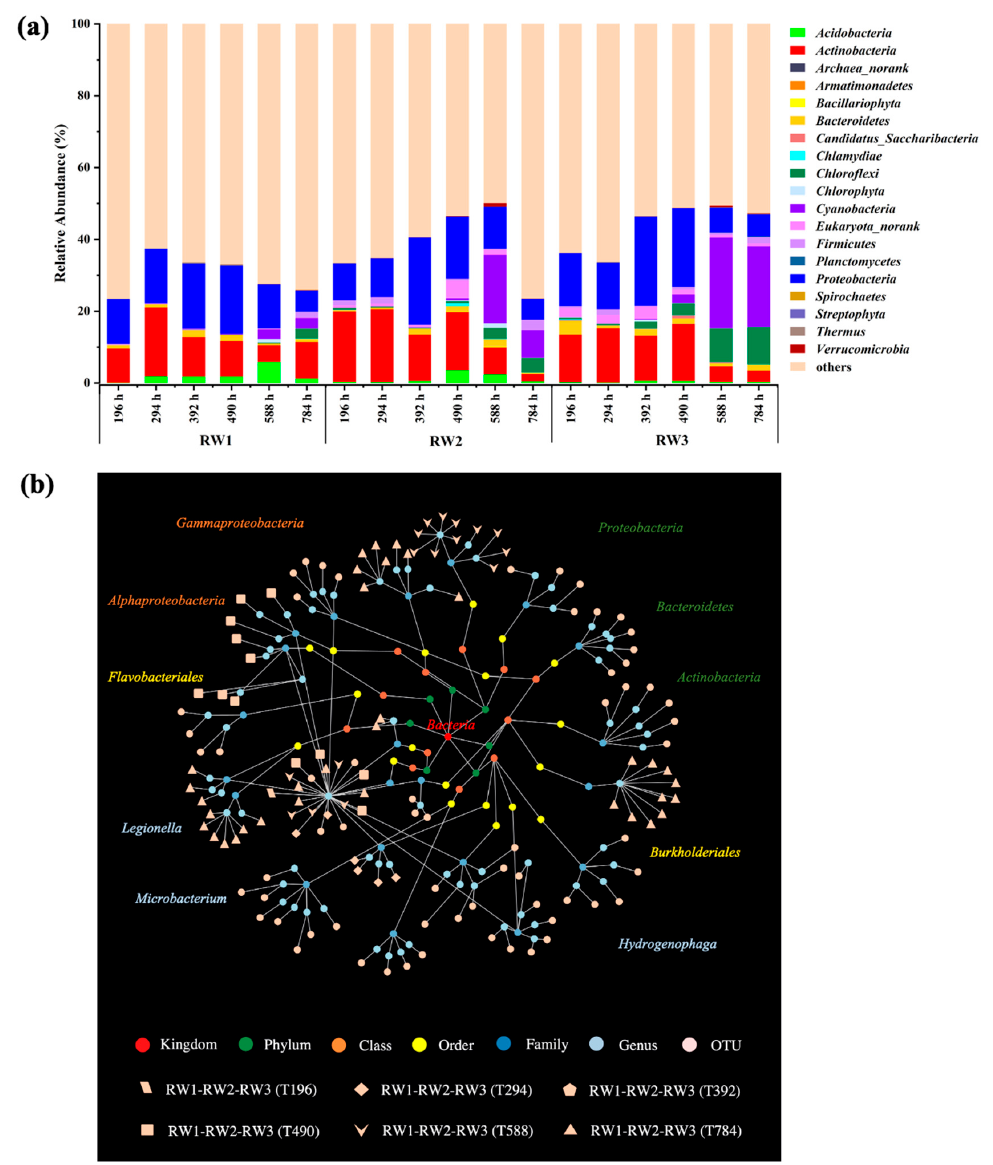
Figure 4. The taxonomic composition of bacteria and community structure in biofilms formed by three types of water sources. ( a ) The relative abundances of phyla in different samples; ( b ) Tree diagram of bacterial community classification in different samples. The nodes in the network diagram represent species at each classification level. The connection between the nodes represents the classification path of species from the root (bacteria) to the OTU level, and the OTU is the lowest classification node. Species at different levels were labeled with different colors, and the average relative abundance of species in the sample was indicated. Nodes with different shapes represent OTUs with significant differences ( p < 0.05) in different comparisons. Multiple bacteria with significant differences are labeled with different colors depending on the level.